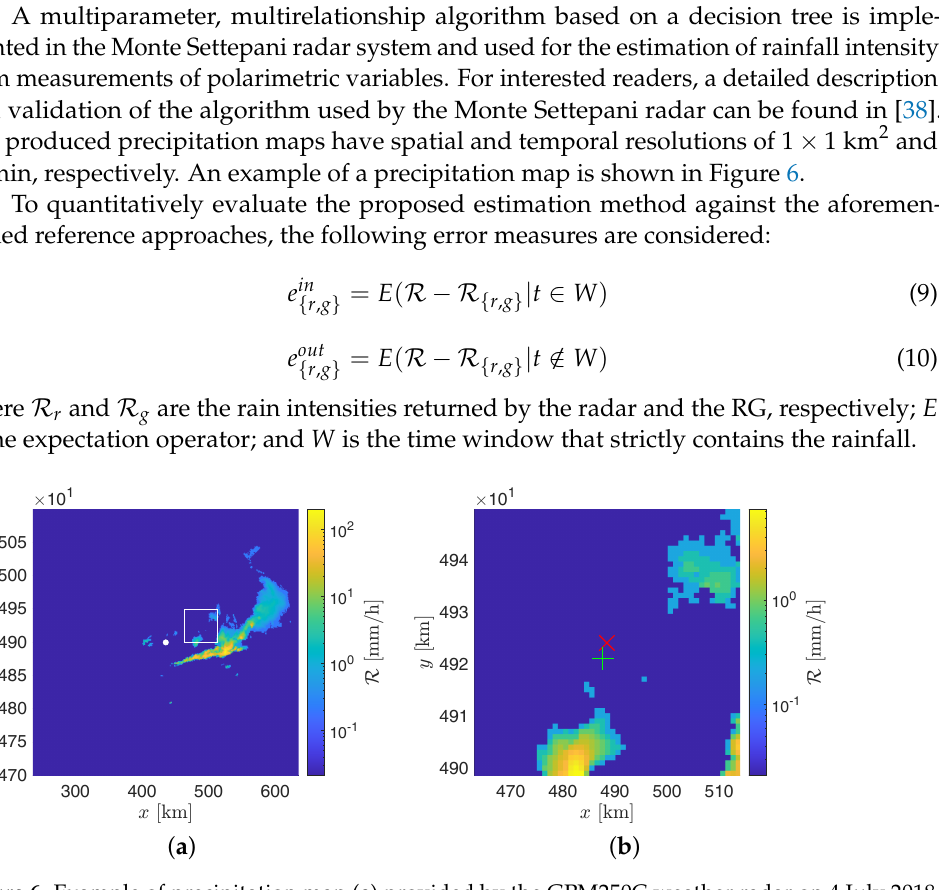
Figure 6. Example of precipitation map ( a ) provided by the GPM250C weather radar on 4 July 2018, at 03:50 UTC. The radar position is indicated by the central white dot. The area containing the Monte Scarpino landfill and the RG at Monte Gazzo is delimited by the white square, whose side length is about 50 km. A zoomed view of this area is provided in subfigure ( b ), where the red cross is centered on the landfill and the green plus sign indicates the